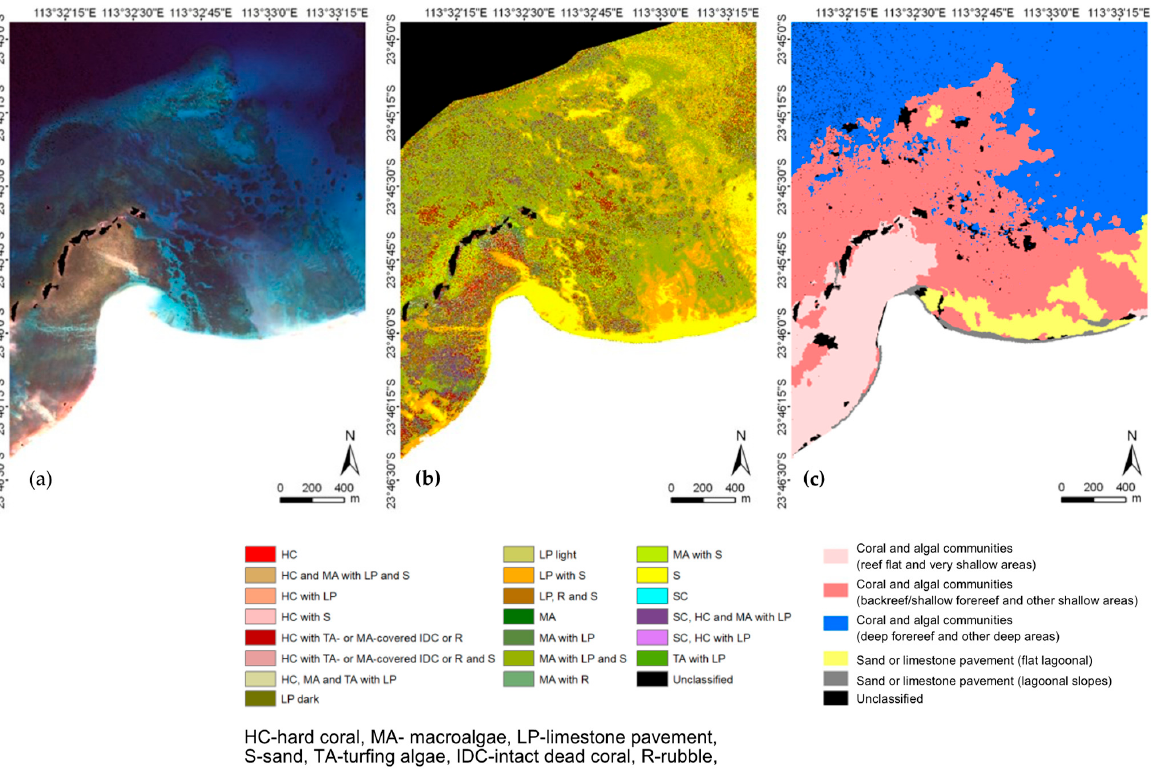
Figure 13. Gnaraloo Bay area ( a ) subsurface reflectance, ( b ) pixel-based benthic habitat map, and ( c ) geomorphic classes. ( c ) geomorphic